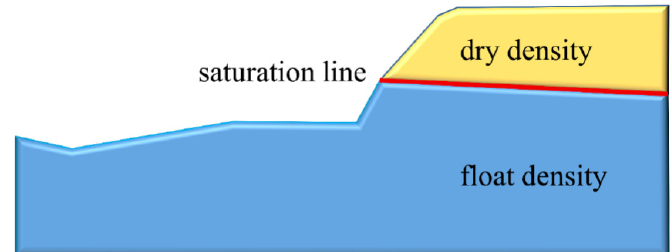
Figure 13. Influence of the rising force.